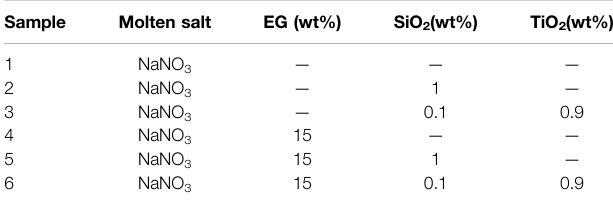
TABLE 2 | composition of different